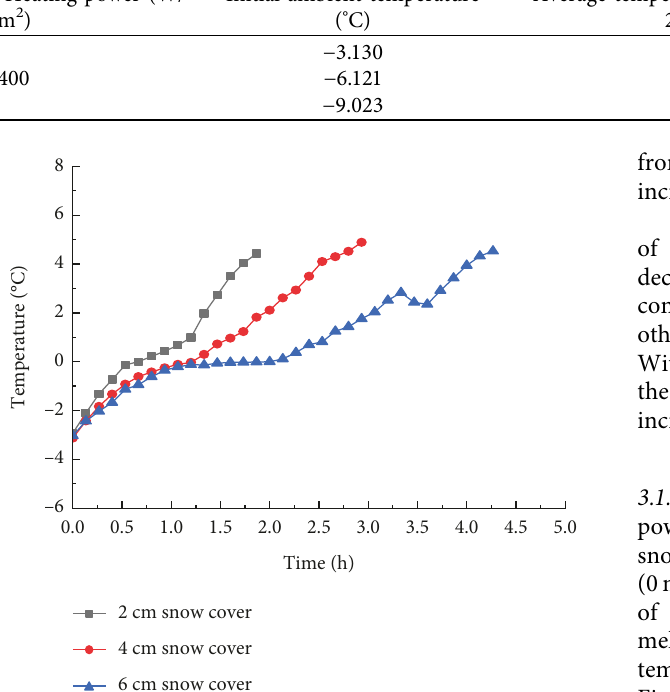
Table 7: Rates of the temperature increase of the specimen surface at different initial ambient temperatures. Heating power (W/ m 2 )